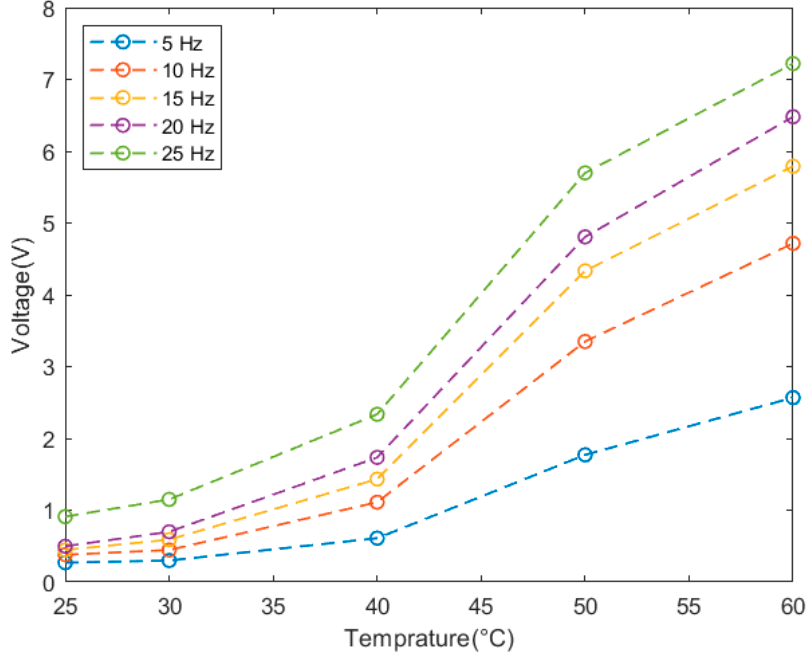
Figure 6. Voltage measurement in temperature domain at various frequencies.